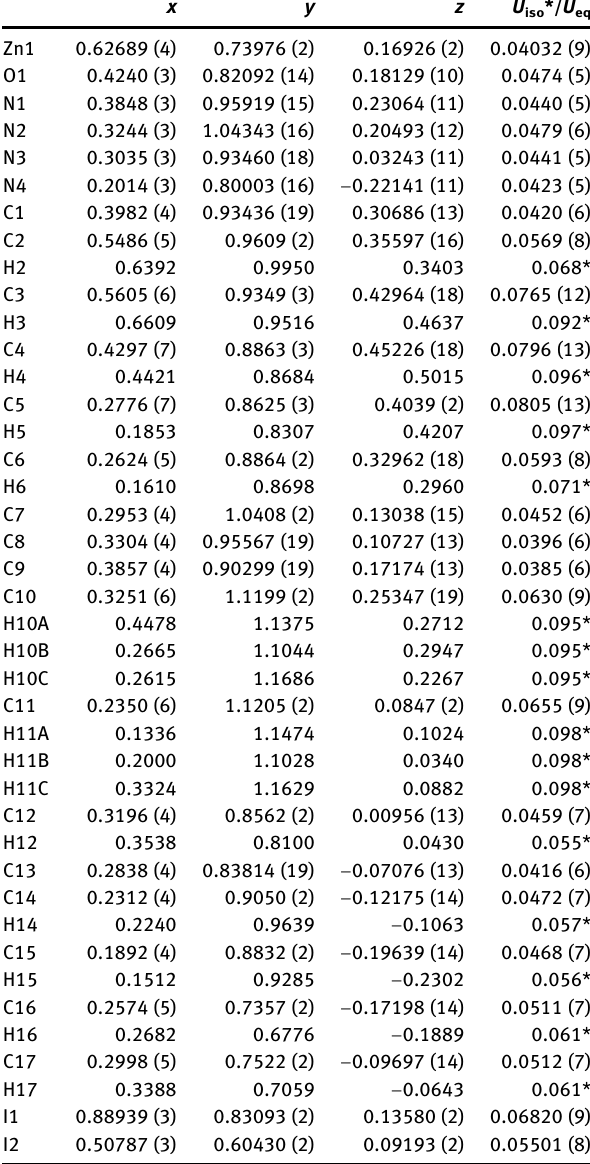
Table  : Fractional atomic coordinates and isotropic or equivalent isotropic displacement parameters (Å 